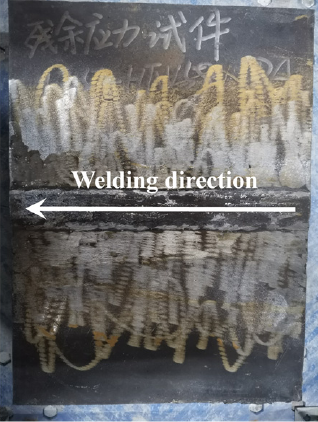
Figure 5. Welding direction.